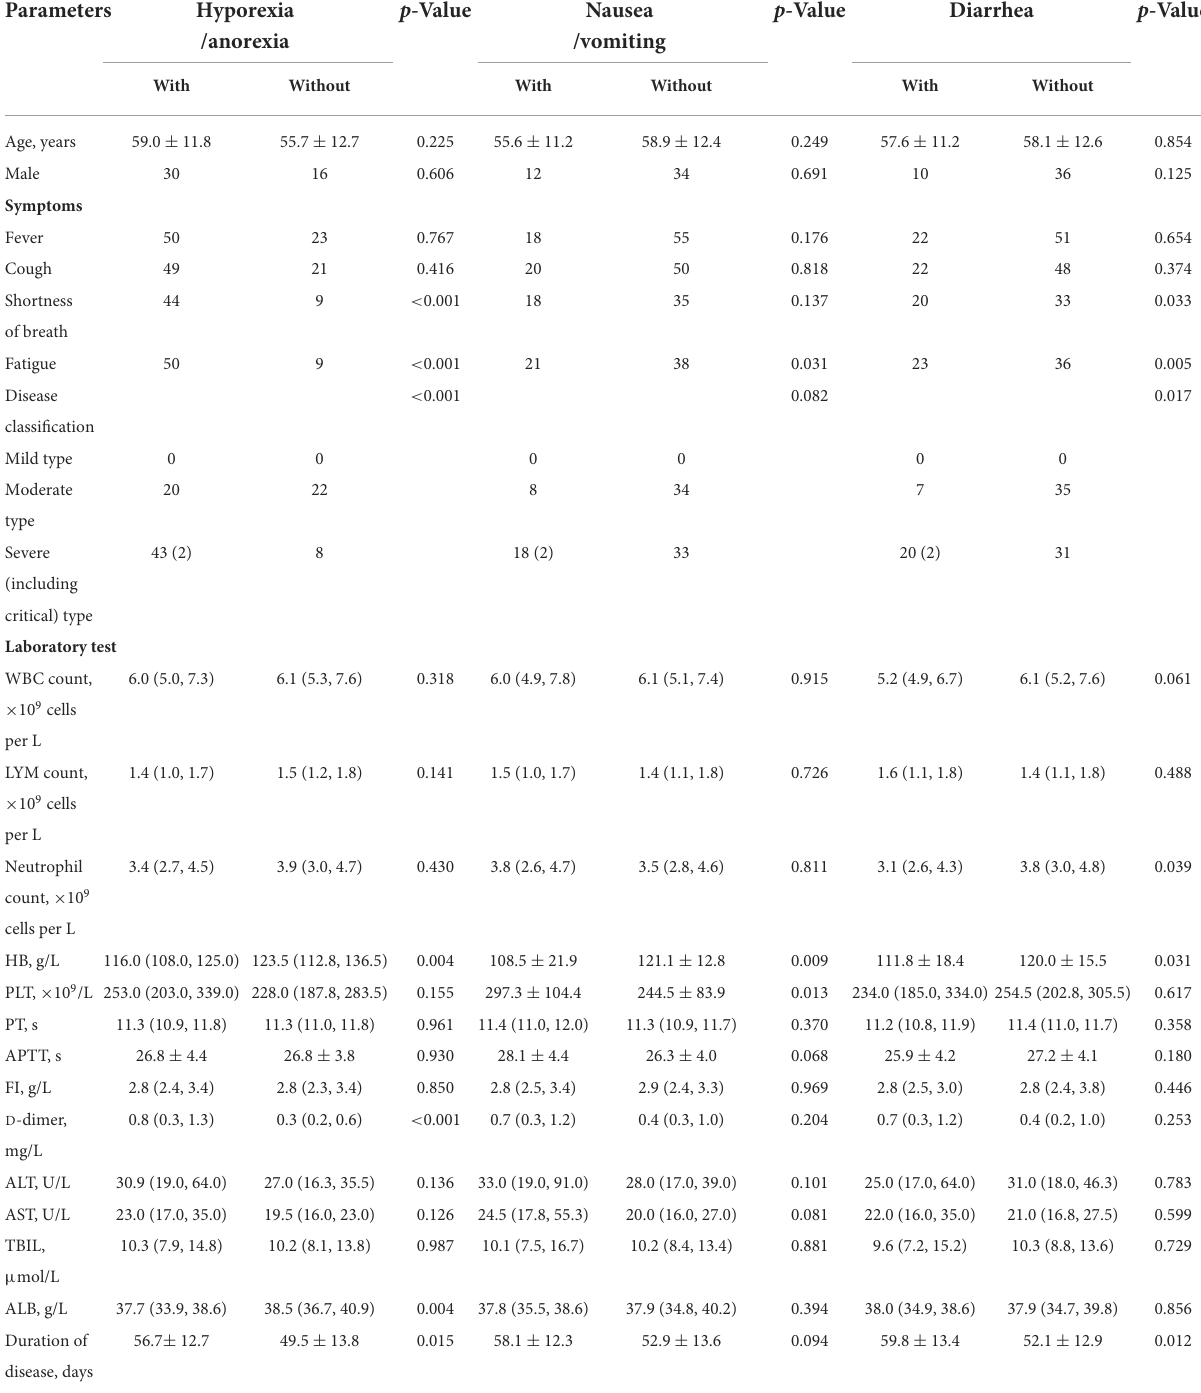
TABLE 3 The subgroup analysis of patients with and without GI symptoms.